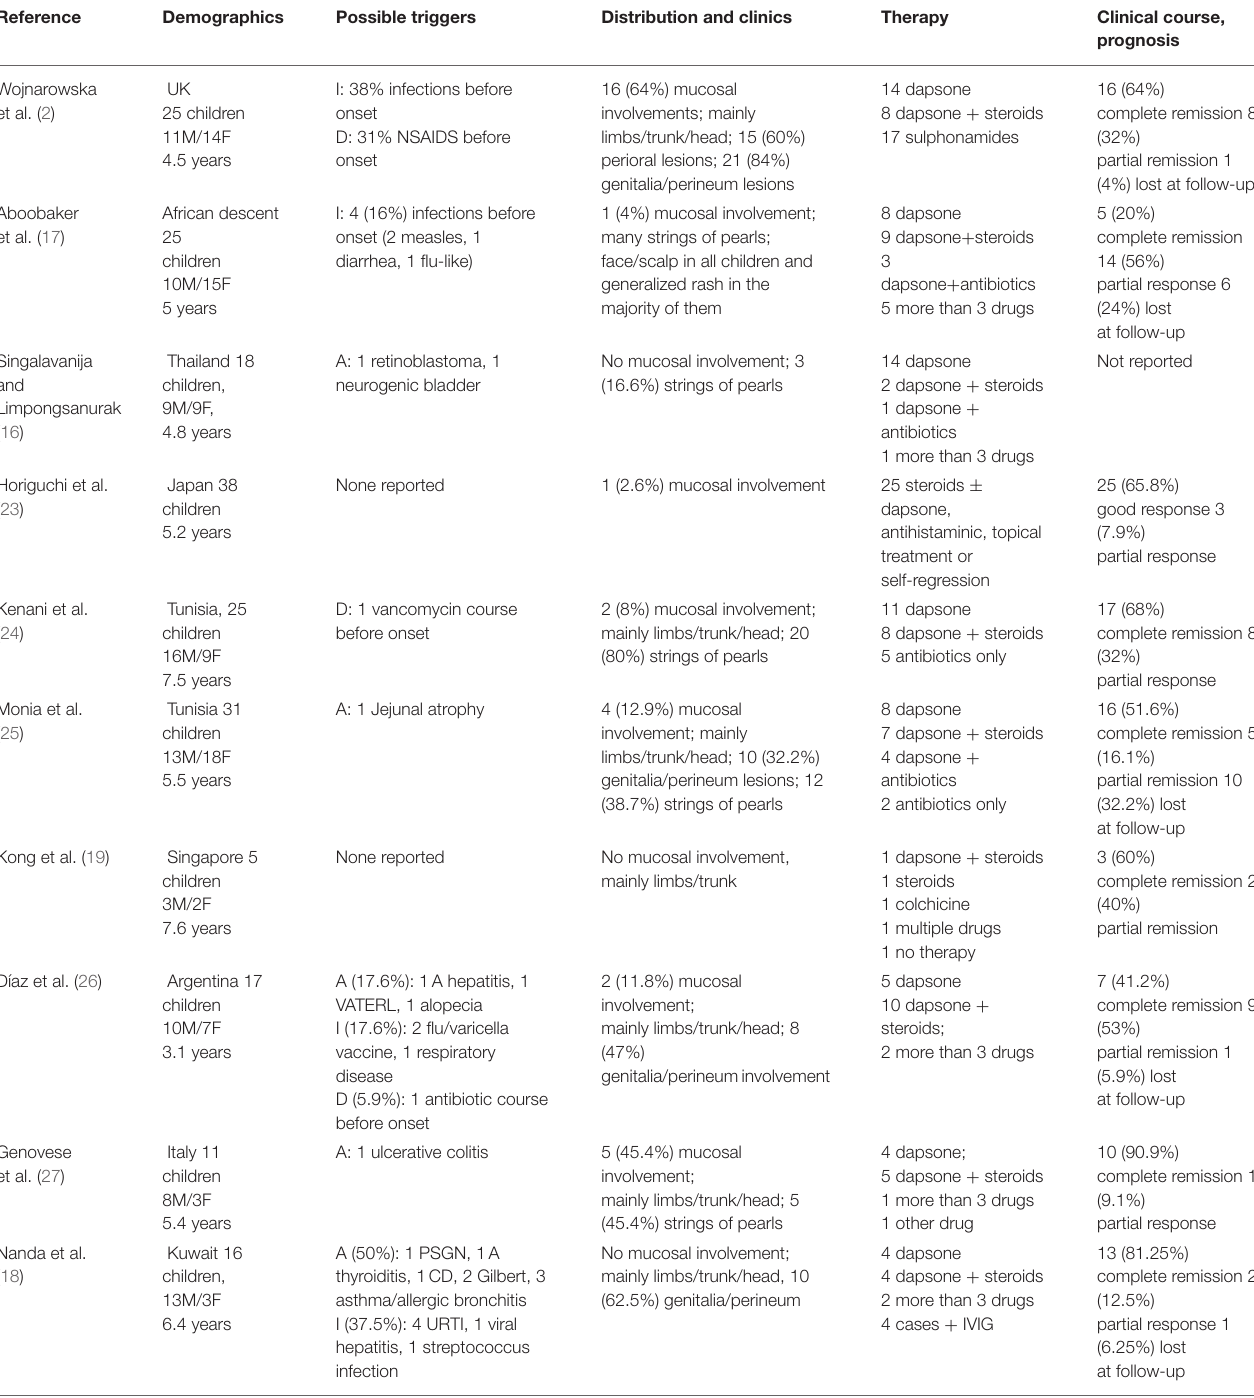
TABLE 1 | Pediatric cases of LABD: epidemiological and clinical